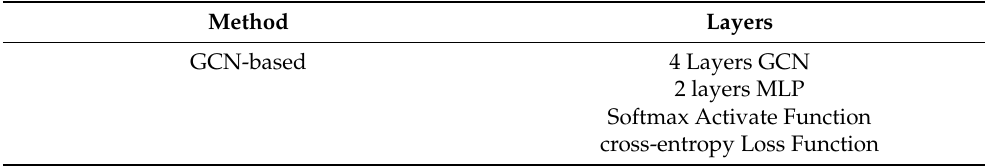
Table 2. The architecture of the node classification model